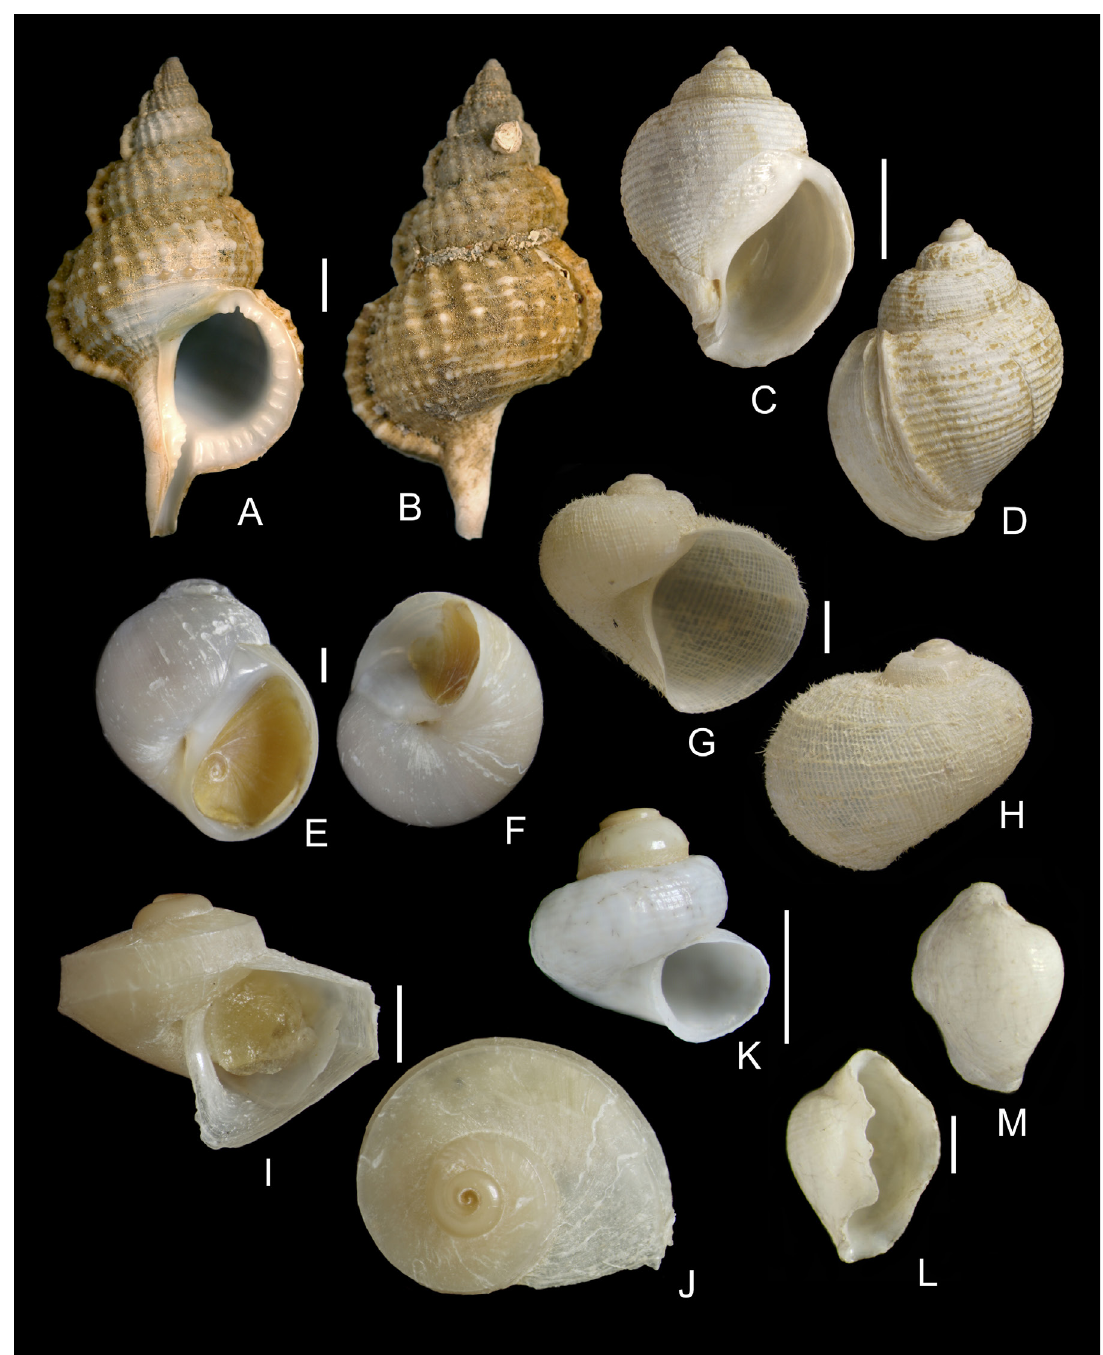
Fig. 22. Ranellidae, Cassidae, Naticidae, Capulidae, Haloceratidae, Ovulidae. A–B . Ranella olearium (Linnaeus, 1758), BANGAL 0711, V6, 909 m, 90 mm. C–D . Oocorys sulcata P. Fischer, 1884, BANGAL 0711, V8, 1565 m, 32 mm. E–F . Euspira subplicata (Jeffreys, 1885), BANGAL 0711, V10, 1720 m, 7.5 mm. G–H . Torellia delicata (Philippi, 1844), BANGAL 0711, V10, 5.2 mm. I–J . Haloceras cingulatum (Verrill, 1884), live-collected specimen, BANGAL 0711, V10,